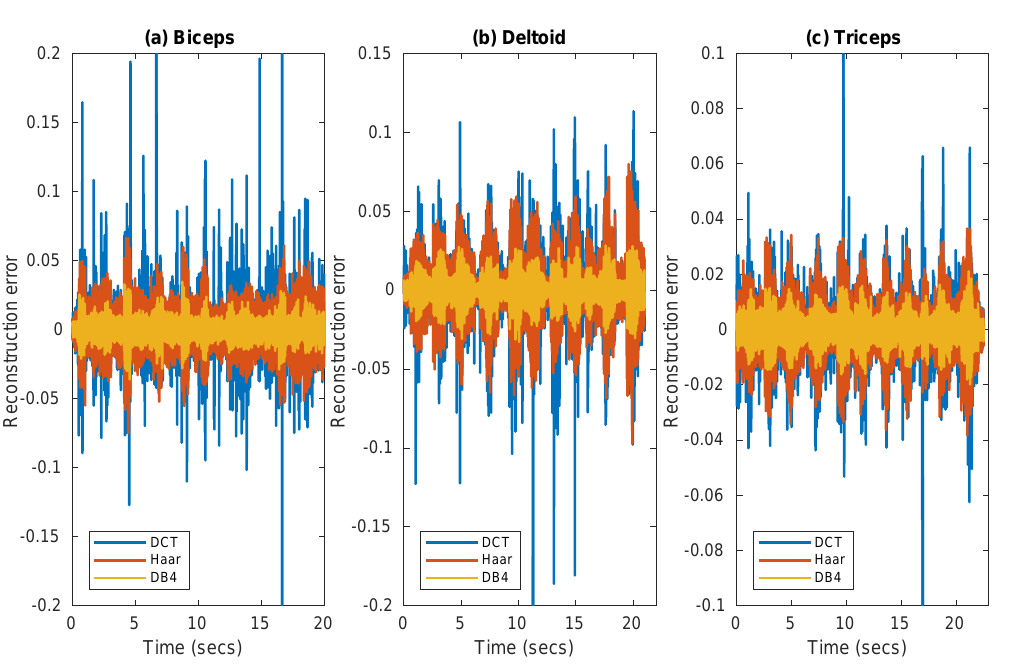
Figure 1. Reconstruction error of EMG signal as achieved with convex optimization, using DCT, Haar, and DB4 bases in frames corresponding to three muscles ( a ) Biceps ( b ) Deltoideus ( c )